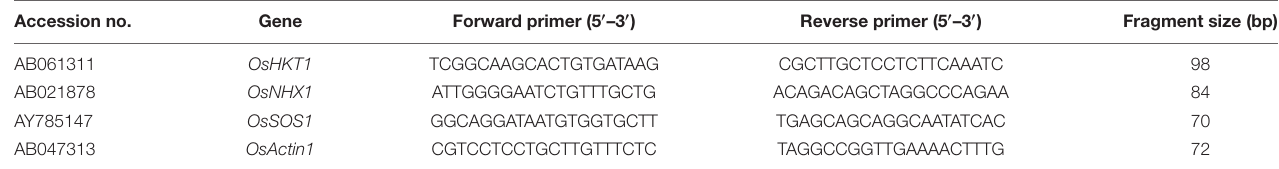
TABLE 1 | Primer list for polymerase chain reaction analysis. Accession no. Gene Forward primer (5 (cid:48) –3 (cid:48) ) Reverse primer (5 (cid:48) –3 (cid:48) ) Fragment size